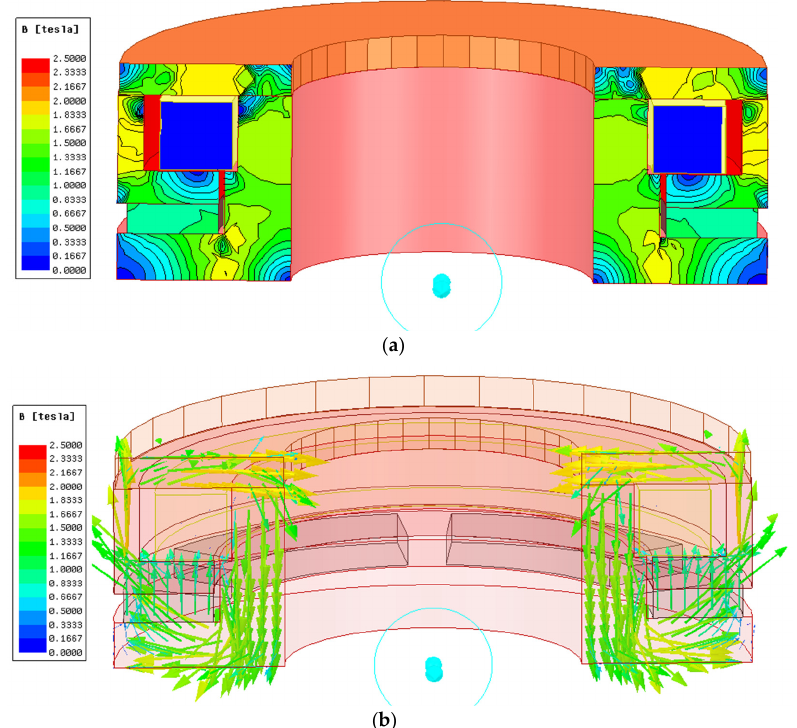
Figure 9. Magnetic flux distribution when unenergized. ( a ) Magnetic flux density cloud image. ( b ) Magnetic flux vector distribution